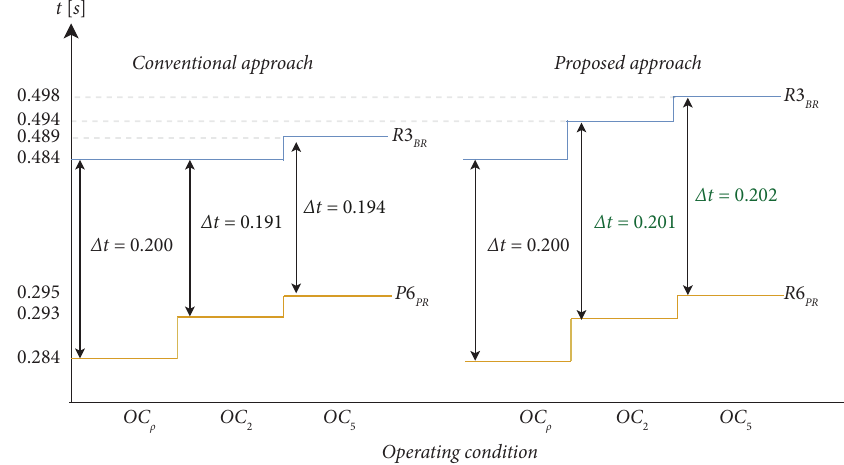
Figure 7: Operating times of conventional and proposed approach for relay pair in diferent